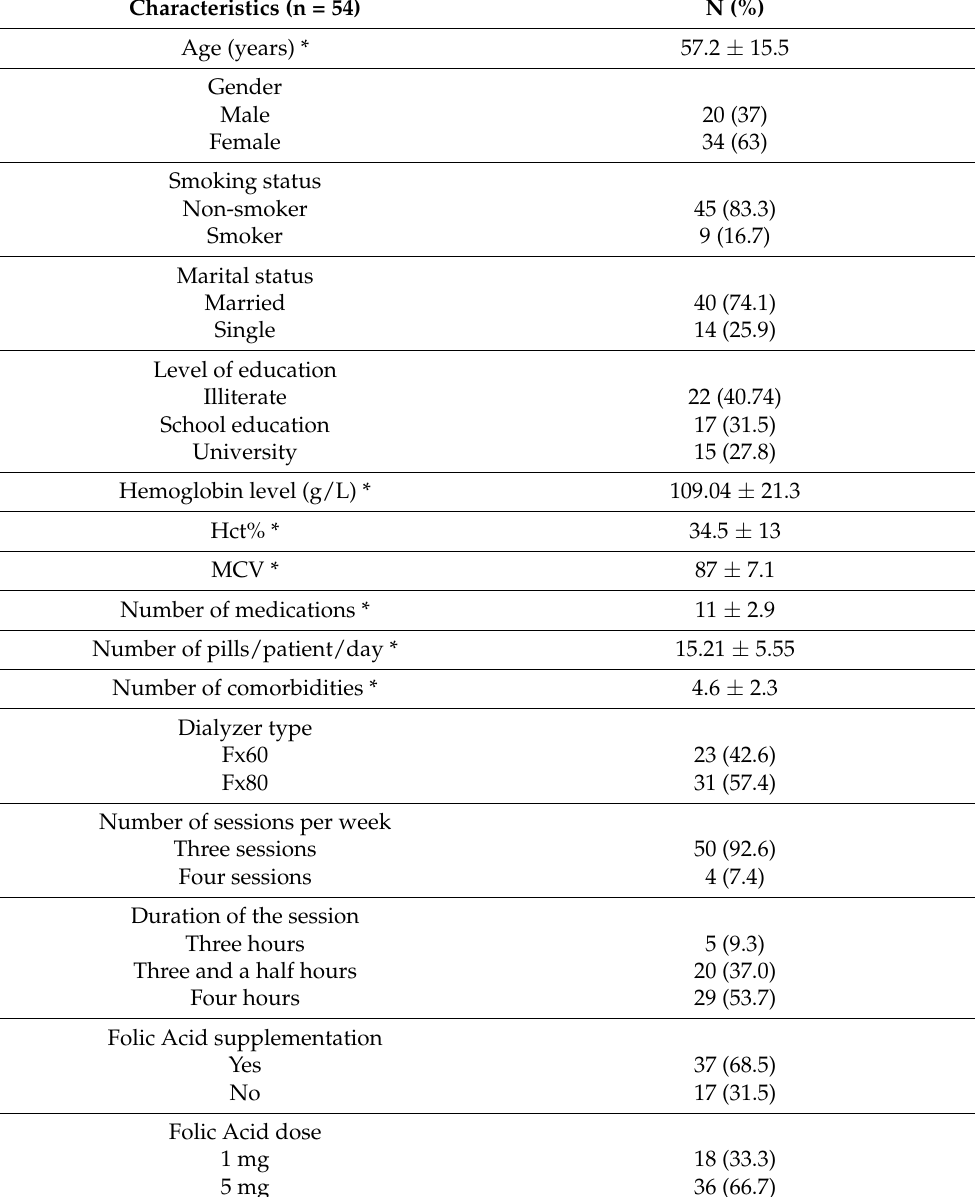
Table 1. Patient demographic